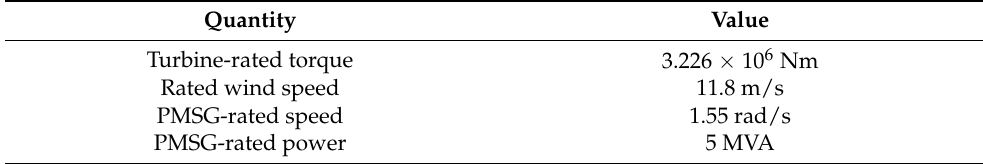
Table 2. Parameters of the WTG used in the case study.